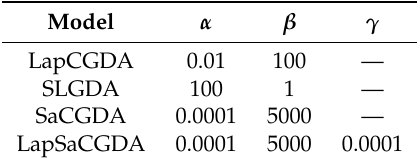
Table 7. Optimal parameters settings for LapCGDA, SLGDA, SaCGDA and LapSaCGDA on the Indian Pines